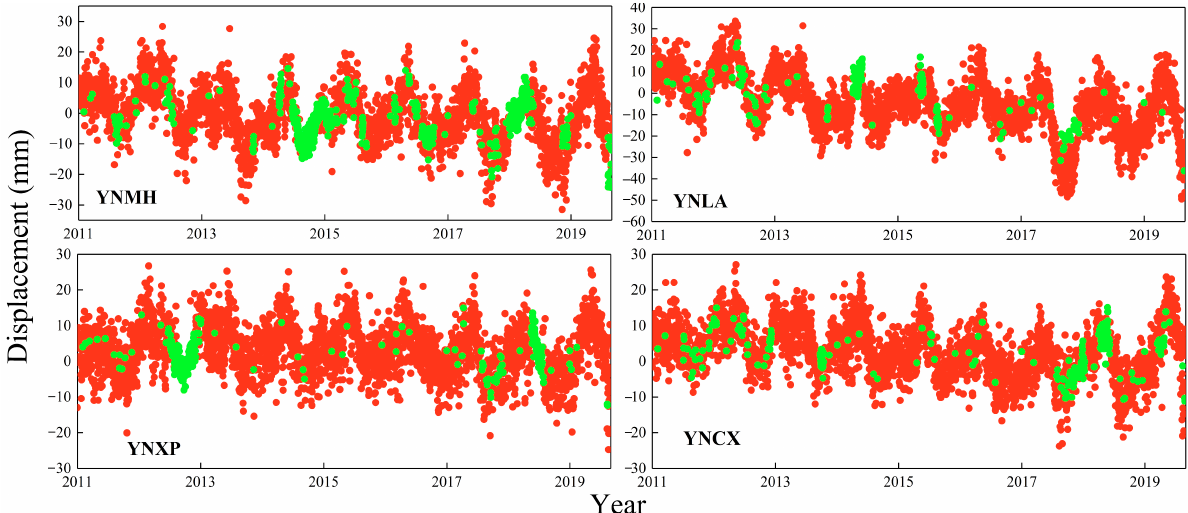
Figure 2. The RegEM interpolation result of YNMH, YNLA, YNXP, and YNCX stations. The red and green dots represent the vertical GPS time series and interpolation data, respectively.